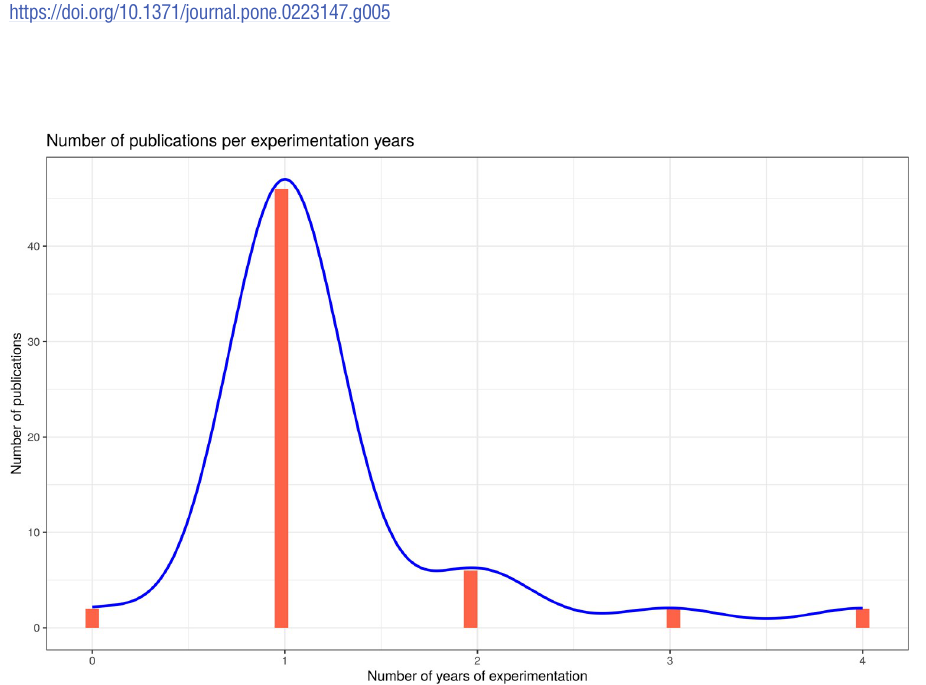
Fig 6. Number of publications per experimentation years for the 58 publications from 1959 to 2017 with indications of it.